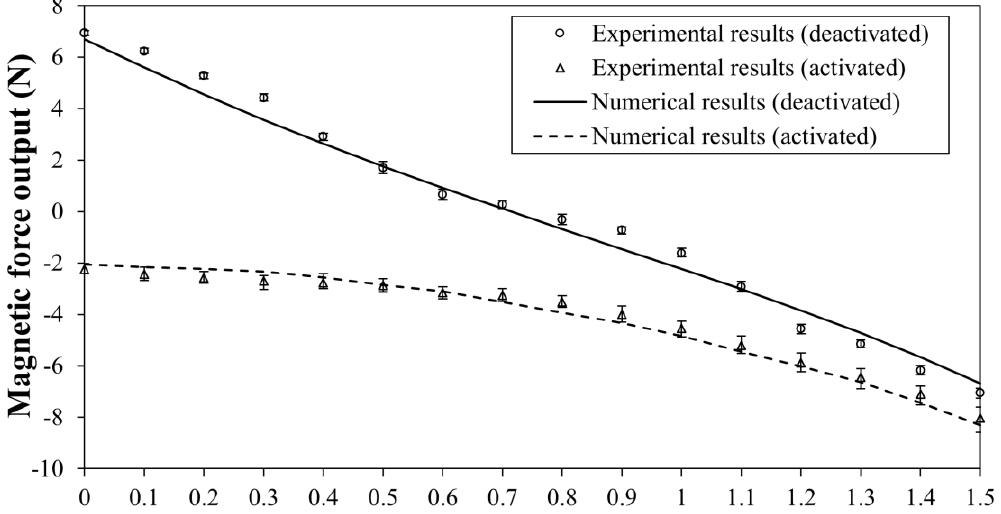
Figure 7. Magnetic force output along the actuation stroke of the actuator.